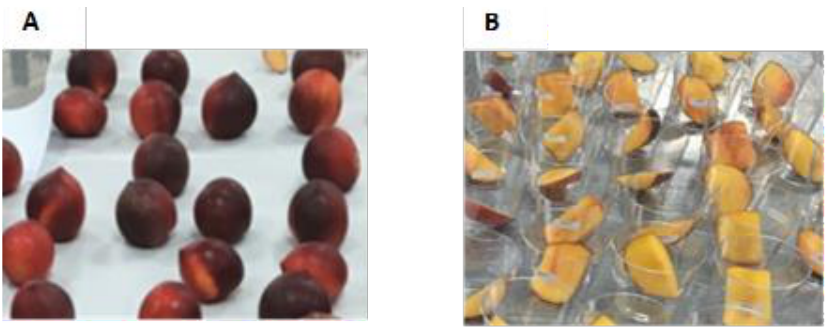
Figure 1. ‘Big Top’ peach samples use for sensorial analysis ( A ) samples on unpacking, ( B ) samples as prepared for tasting at Cardiff sites.